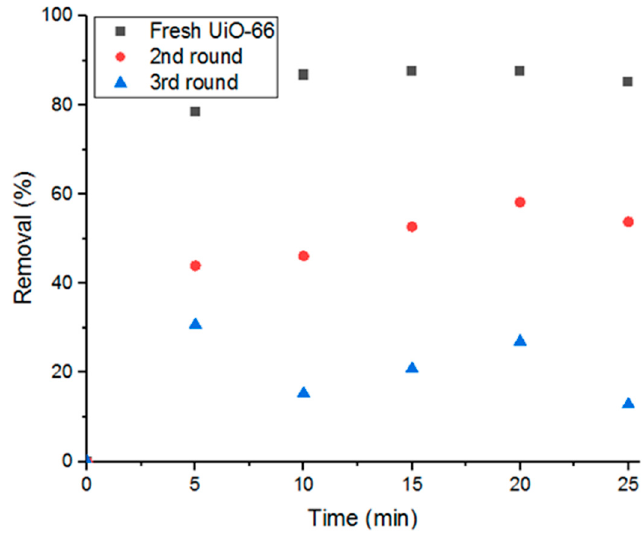
Figure 11. Decrease of removal percent with cyclic usage of adsorbent.